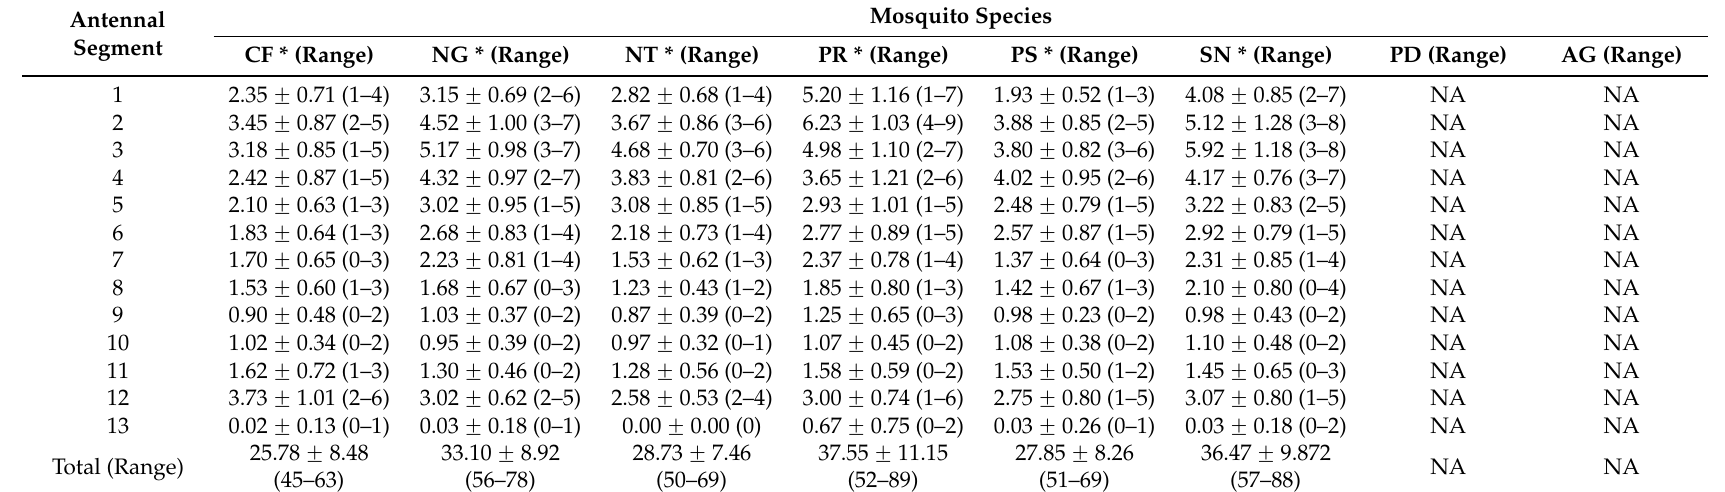
Table 5. Mean distributions of sensilla coeloconica on the 13 antennal flagellomeres of females of the six species of the Hyrcanus Group (30 females/species, n = 60).